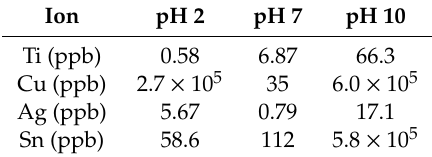
Table 5. ICP-MS of solution containing submerged Ti rods with external amalgam at pH 2, 7, and 10.